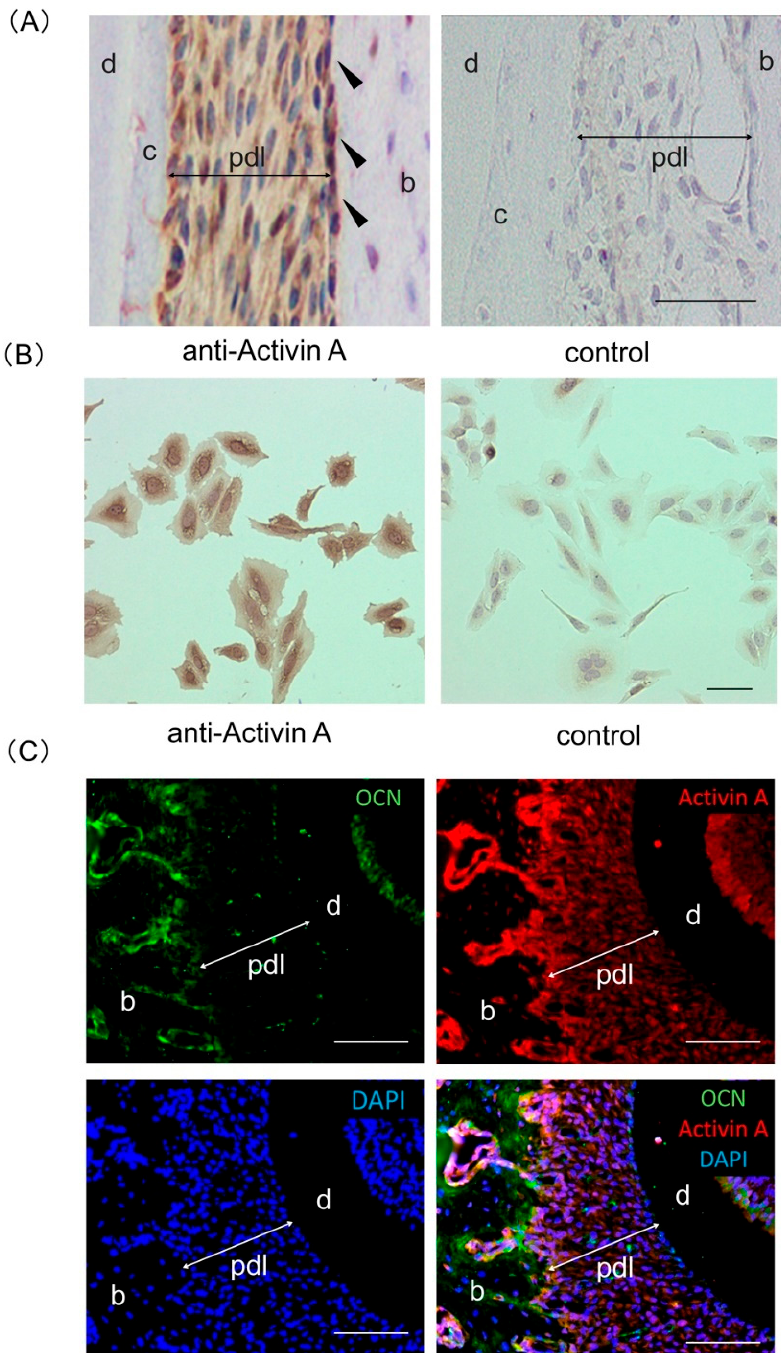
Figure 1. Expression of activin A in rat periodontal ligament (PDL) tissue and Saos2 cells. ( A ) Sagittal sections of rat PDL tissue were used for immunohistochemical analysis. A positive reaction with an anti-activin A antibody was detected in the PDL tissue and was particularly marked in the osteoblastic layer (black arrowhead). ( B ) Immunopositive staining against an anti-activin A antibody was found in the cytoplasm of Saos2 cells. Control IgG was used as a negative control. Hematoxylin was used for the staining of nuclei. Experiments were performed in duplicate. ( C ) Horizontal sections of rat PDL tissue were used for immunofluorescent analysis. Expression of activin A (red) and osteocalcin (OCN; green) were colocalized in osteoblastic layer of the alveolar bone (yellow). Nuclei were stained with 4,6-diamidino-2-phenylindole (DAPI; blue). b, alveolar bone; c, cementum; d, dentin; pdl, periodontal ligament. Bars = 100 µm.